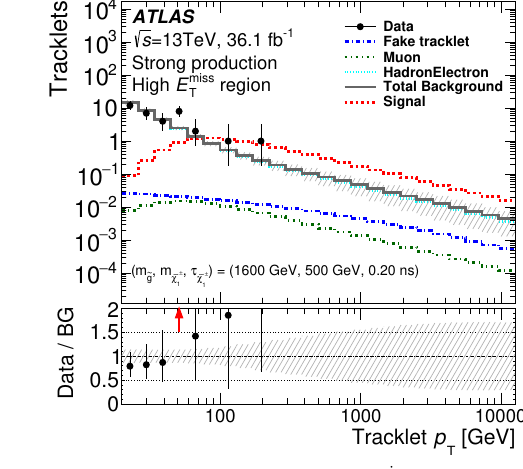
region. region. Figure 7 . Pixel-tracklet p T spectrum in various regions: (a) electroweak channel in the low- E miss region, (b) strong channel in the low- E miss region, (c) electroweak channel in the high- E miss T T T region, and (d) strong channel in the high- E miss region. Observed data are shown with markers T and the background components for the background-only (cid:12)t are shown with lines. In the strong channel, total background lines overlap hadron and electron background lines. An example of the expected signal spectrum at (cid:28) = 0 : 2 ns and m = 400 GeV for the electroweak channel ~ (cid:31) (cid:6) 1 ~ (cid:31) (cid:6) 1 and m ~ g = 1600 GeV, m = 500 GeV for the strong channel is overlaid for comparison. The ~ (cid:31) (cid:6) 1 bottom panels show the ratio of the data to the background predictions. The error band shows the uncertainty in the background prediction including both the statistical and systematic uncertainties. Red arrows in the Data/BG ratio indicate bins where the corresponding entry falls outside the plotted